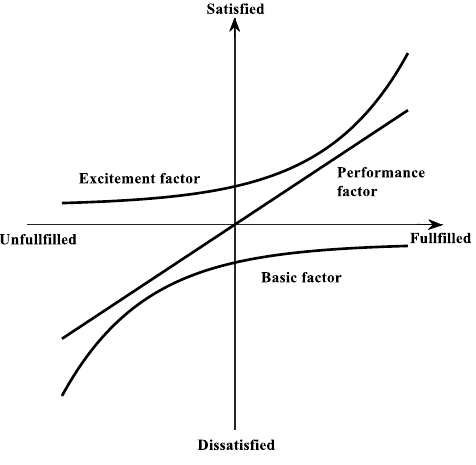
Figure 1. The Kano model.